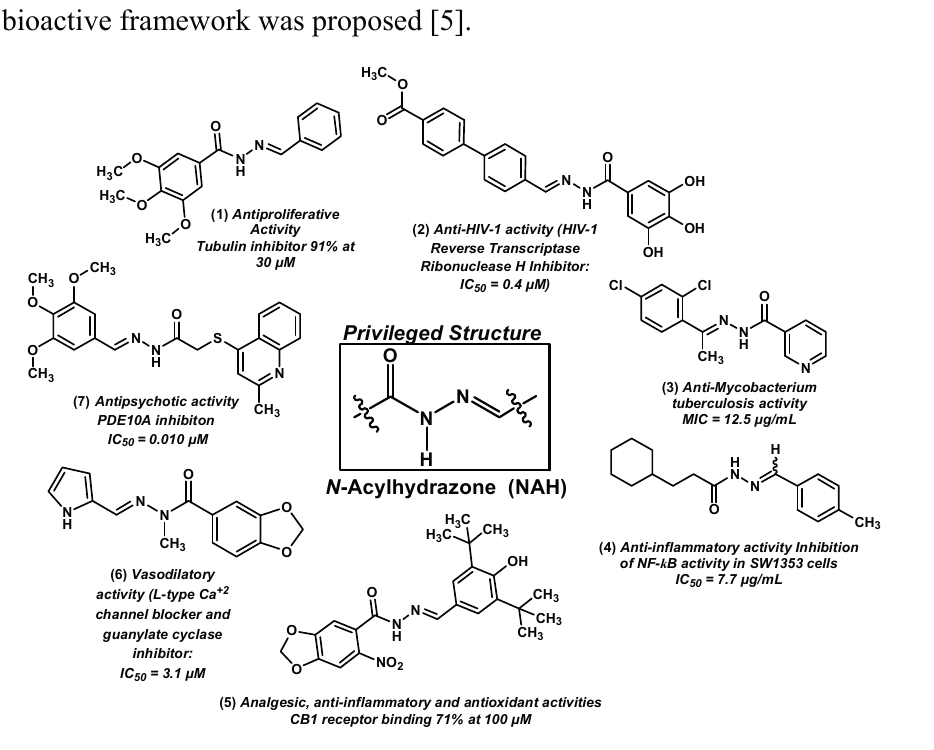
Figure 1. Examples of N -acylhydrazones with different mechanism of action and pharmacological